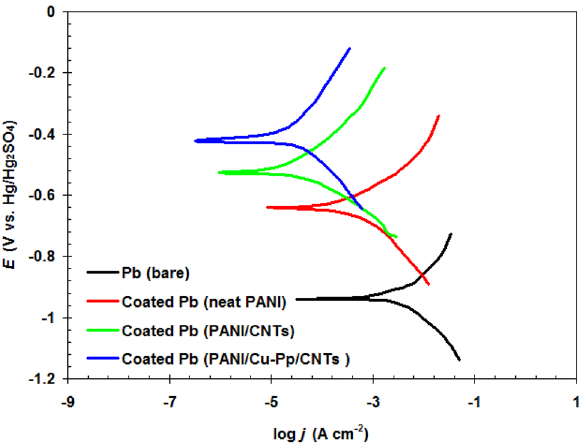
Figure 6. Tafel curves for bare Pb, coated Pb (neat PANI), coated Pb (PANI/CNTs) and coated Pb (PANI/ Cu-Pp/CNTs ) in 5.0 M H 2 SO 4 at 298 K.